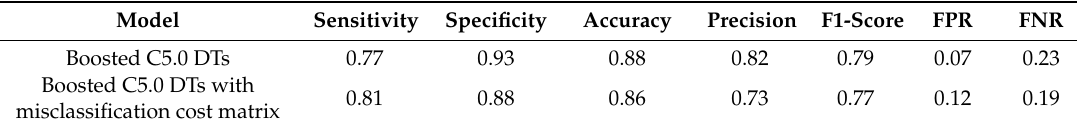
Table 5. Experimental results of boosted C5.0 decision trees (DTs) without and with misclassification cost matrix for the test